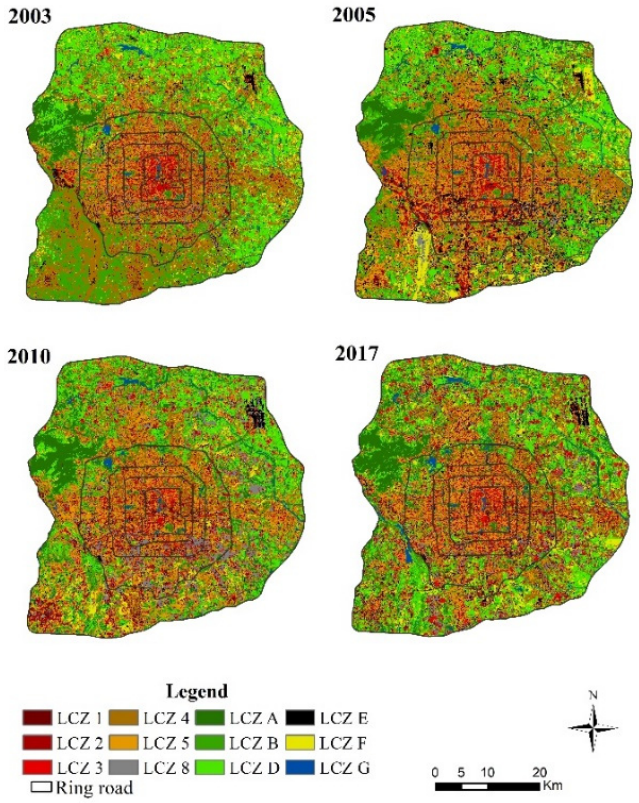
Figure 4. LCZ classification maps (2003, 2005, 2010, and